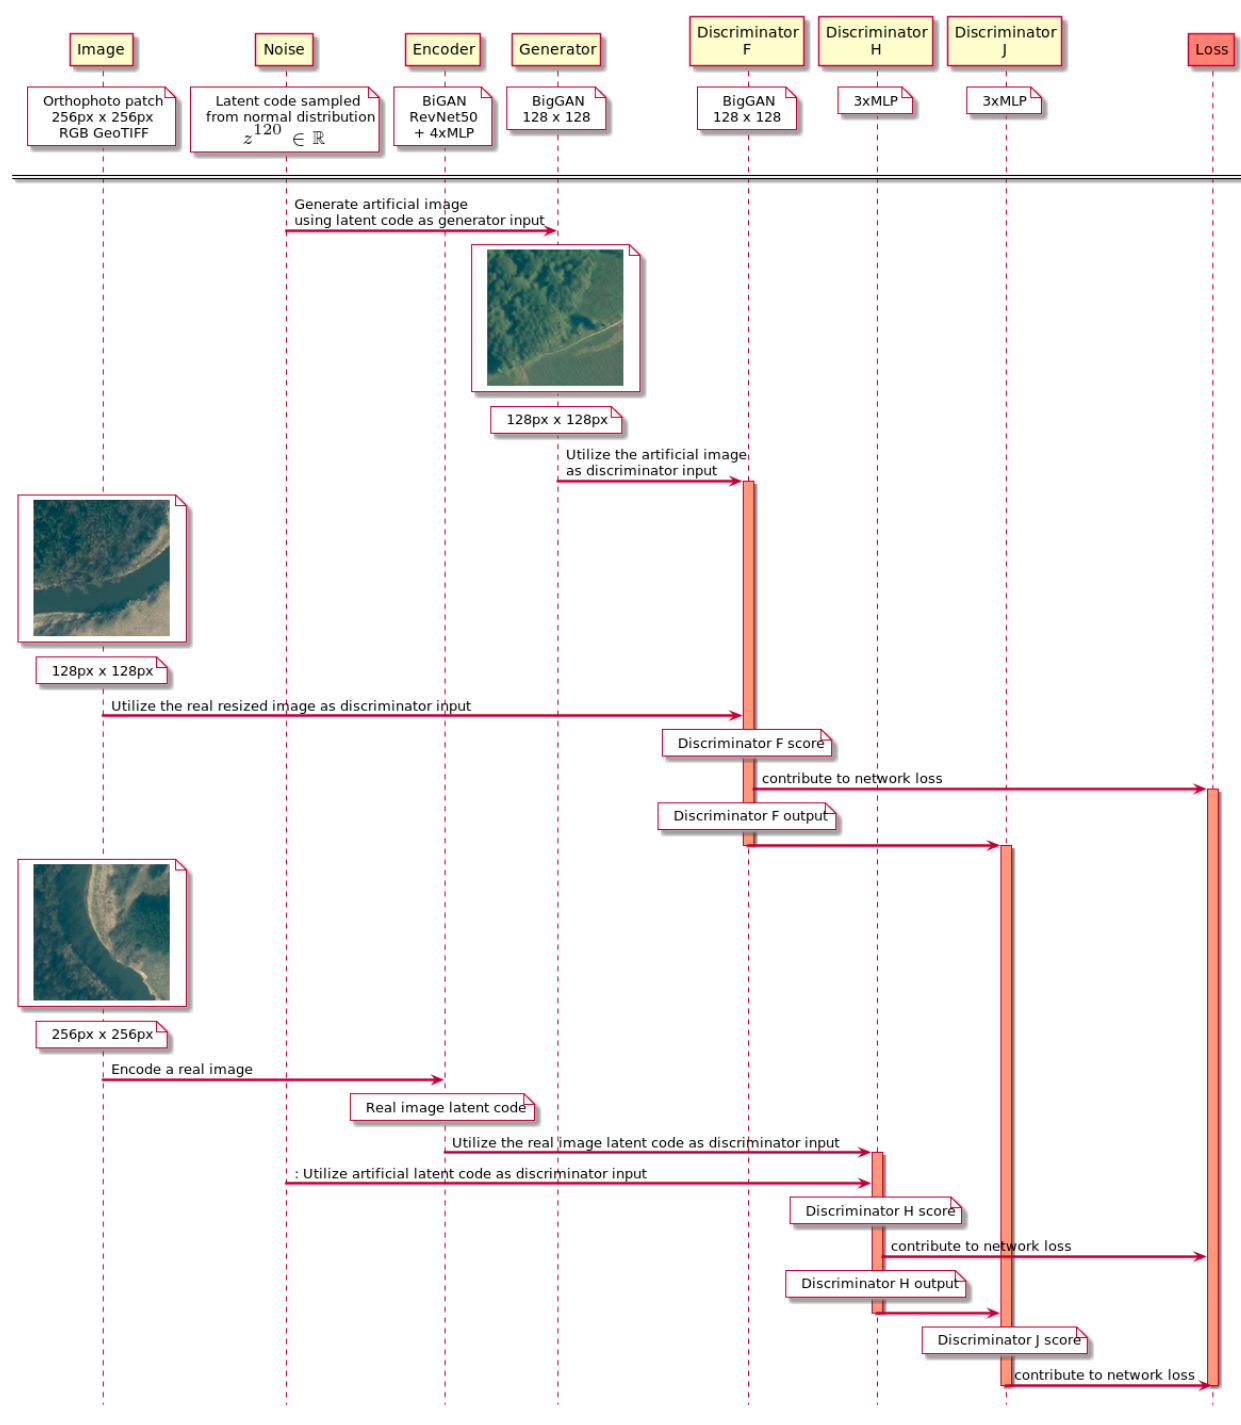
Figure 4. Big bidirectional generative adversarial network (BigBiGAN) training process.